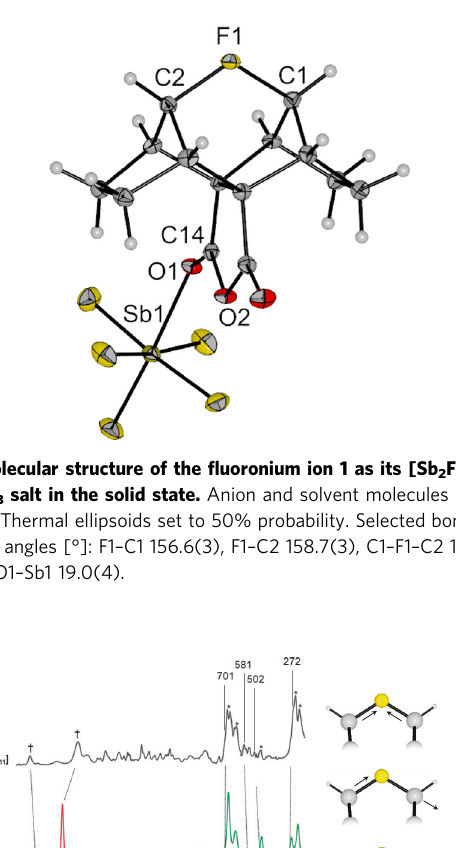
Table 5), and an experimental spectrum of [Cs][Sb 2 F 11 ]. This allows the assignment of characteristic vibrational modes at 581 cm − 1 (calc. plane C – F – C stretching character. Although the region around 690 cm − 1 and 260 cm − 1 are dominated by strong Sb 2 F 11 vibrations two additionally fl uorine-involved modes are tentatively assigned to shoulders at 272 cm − 1 (calc. 291 cm − 1 ) and 701 cm − 1 (calc. 699 cm − 1 ). In addition, the coordination of SbF 5 to one of the carbonyl groups of 1 leads to a splitting of the C = O bands at 1913 ( ν (C = O)) and 1614 ( ν (C = O ⋅⋅⋅ SbF 5 )) cm − 1 (marked by a dagger symbol in Fig. 3). For a complete list of recorded IR vibrations and their assignment see also the methods section.